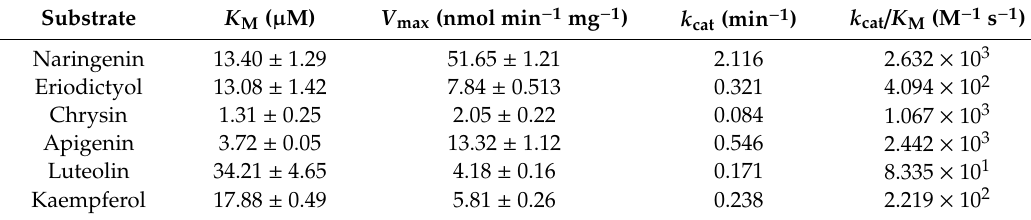
Table 2. Kinetic parameters of recombinant PfOMT3 a